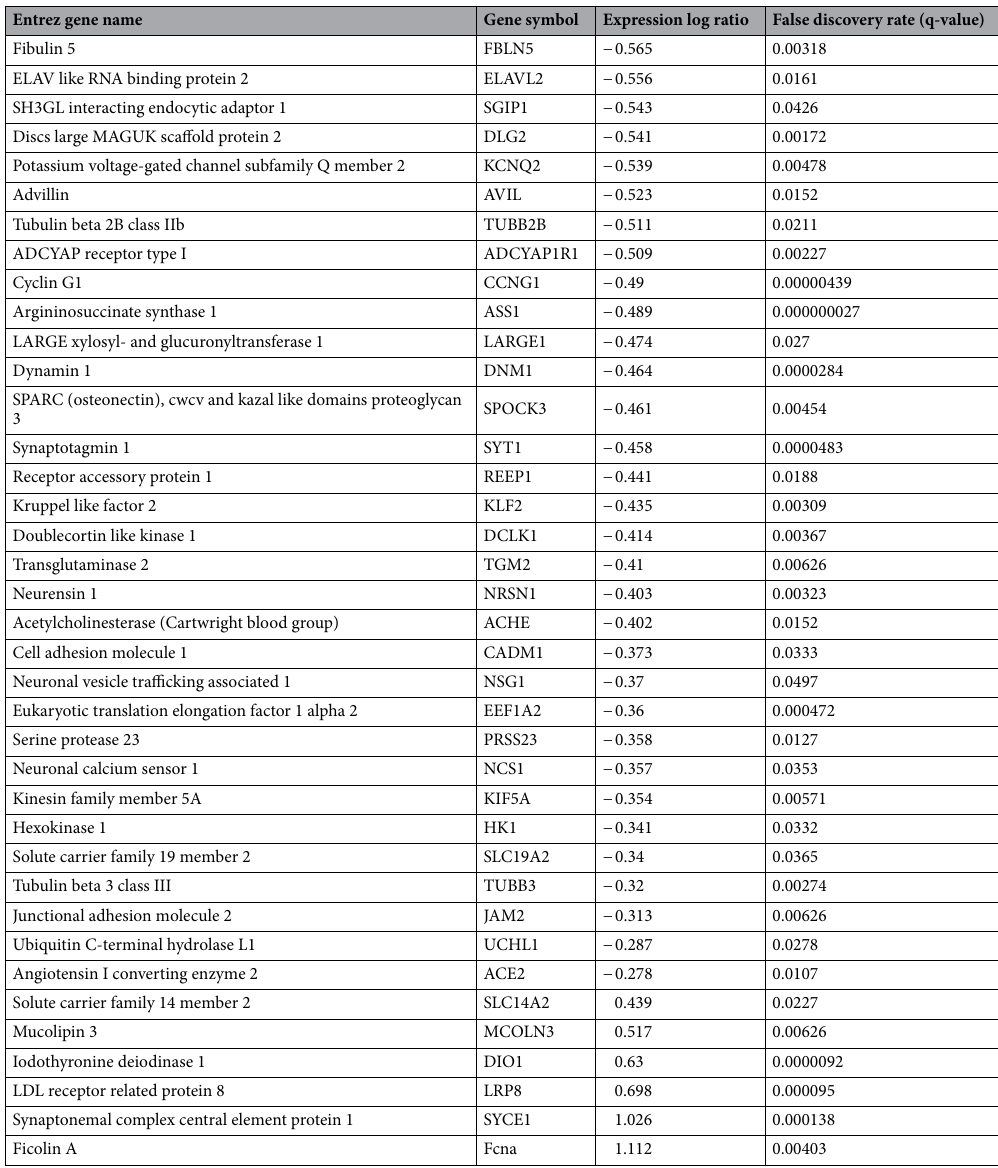
Table 1. Gene expression levels in islets from day 15 pregnant Prlr +/− mice relative to βPrlR +/−